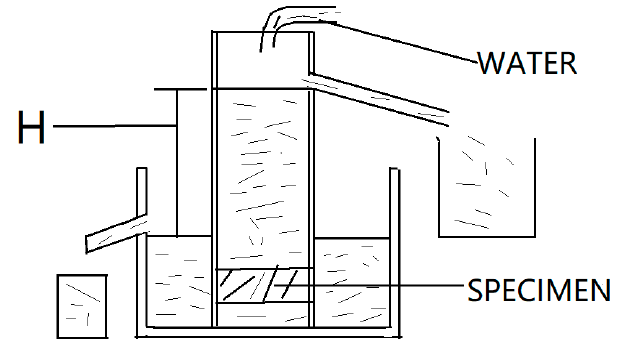
Figure 1. Schematic diagram of permeability measurement setup.